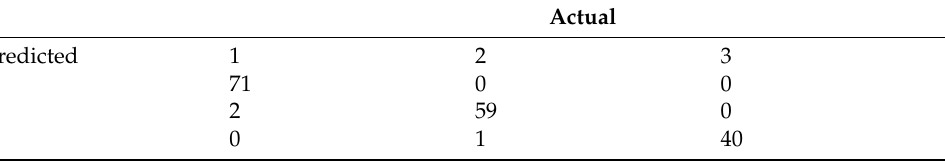
Table 9. Confusion matrix for the decision tree algorithm used in assessing the best algorithm for the LEWS (Training